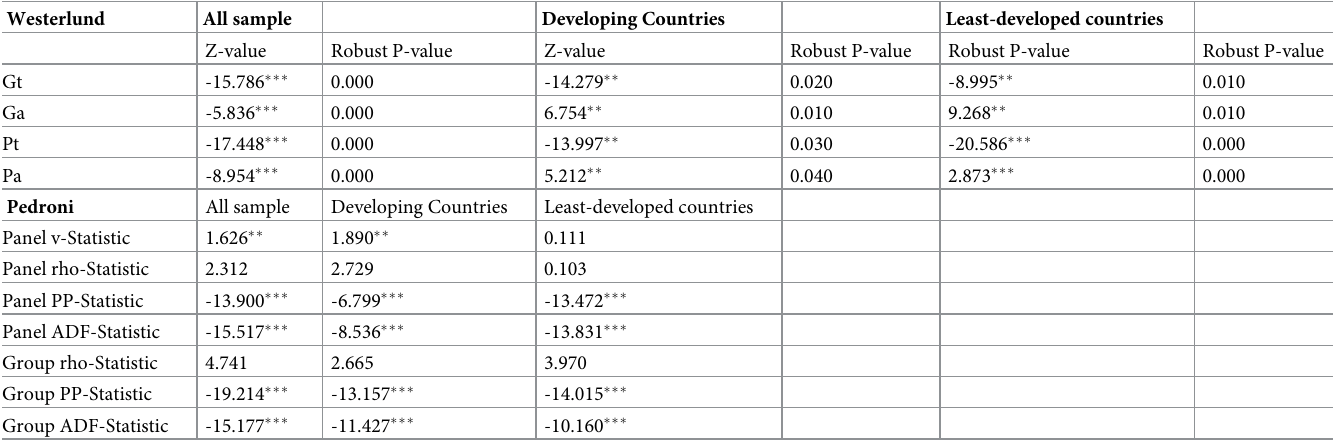
Table 4. Panel cointegration test (Source: Authors’ construct). Westerlund